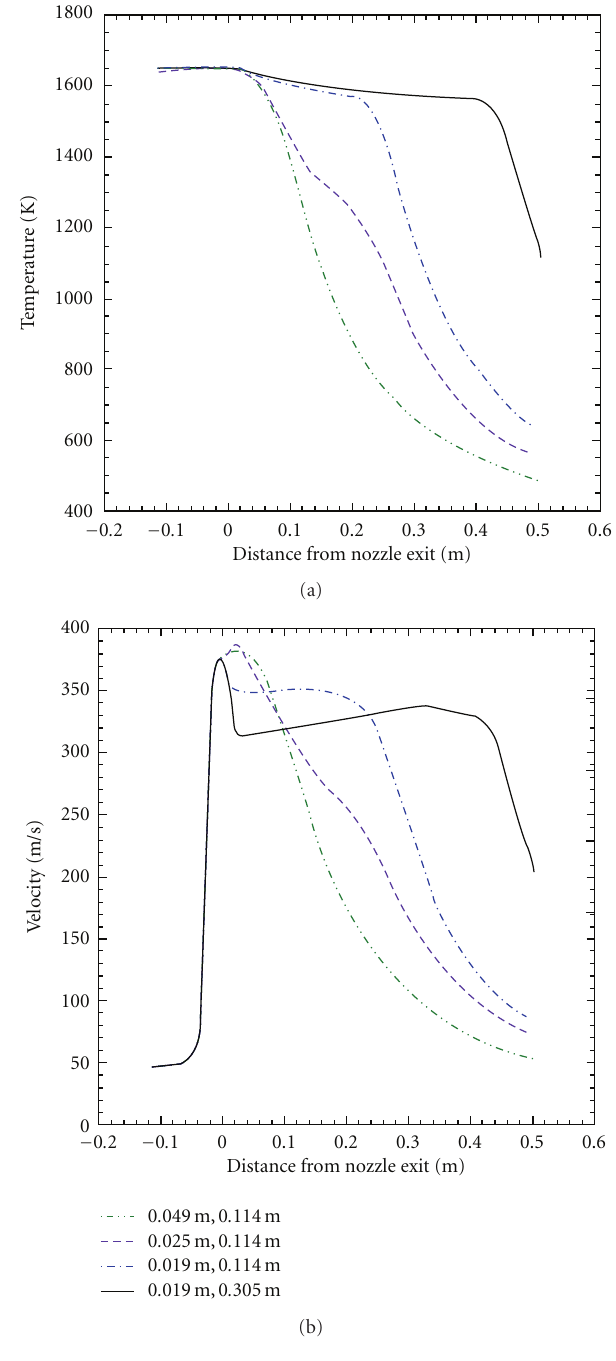
Figure 13: Plots as a function of distance from the nozzle exit of (a) gas temperature and (b) gas velocity for four di ff erent duct diameters (Mach 0.5 nozzle exit conditions).